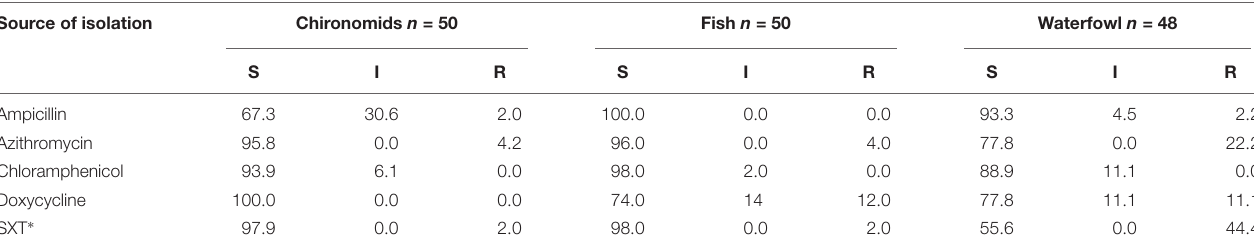
TABLE 3 | Percentage of isolates that were found susceptible (S), intermediate (I), or resistant (R) to different antimicrobial agents in accordance to the Clinical and Laboratory Standards (CLSI, 2018; see also Supplementary Table S3). Source of